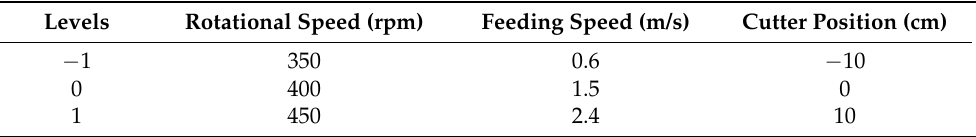
Table 3. Coding levels of the Box − Behnken